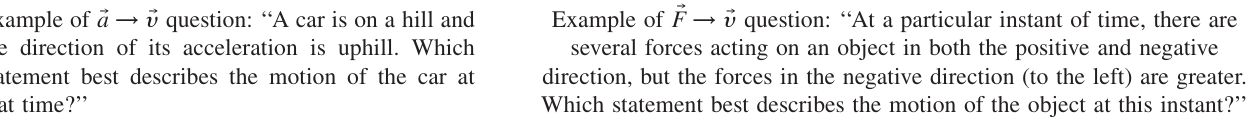
TABLE II. Explanation and examples of the ~x ! ~y notation. A ~x ! ~y question is designed to probe a student’s understanding of how a given vector’s direction ~x is related to another vector’s direction ~y . For example, an ~a ! ~v question provides a simple scenario indicating the direction of the acceleration on an object and asks the student what this implies about the direction of the object’s velocity. Two specific examples from the developed test are provided